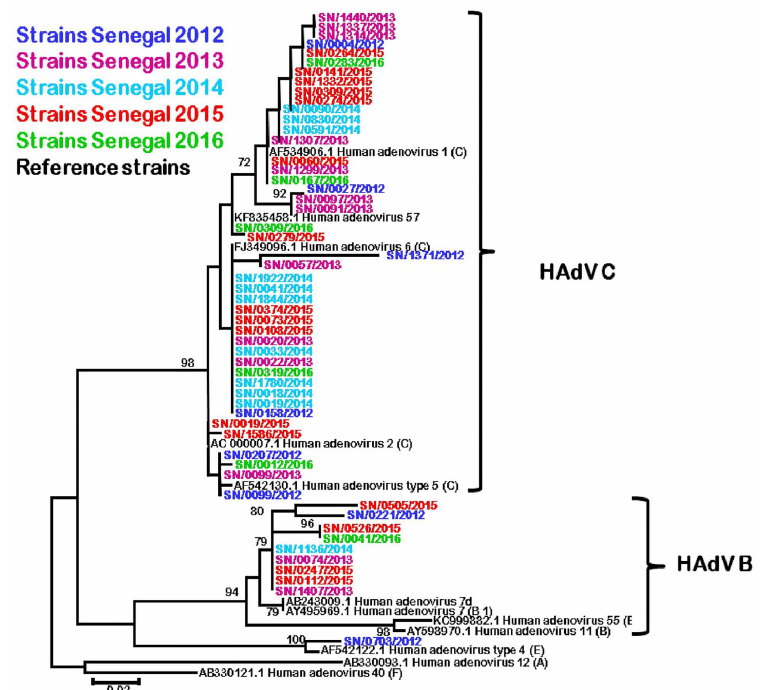
Fig 2. Molecular typing of Human Adenoviruses (HAdV) detected in patients with ILI in Senegal from 2012 to 2016. The last 300 nucleotidesof the adenovirushexon gene were amplified, sequenced, and comparedto published sequences(in black) from GenBank using the neighbor-joining method with 1000 bootstrapreplicateswith MEGA 6 version. Senegalese strains are represented in different colors depending on the year of